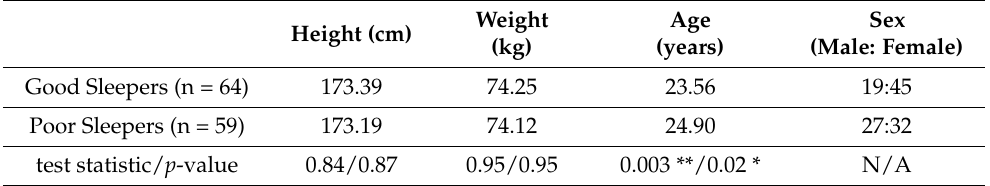
Table 1. Participant